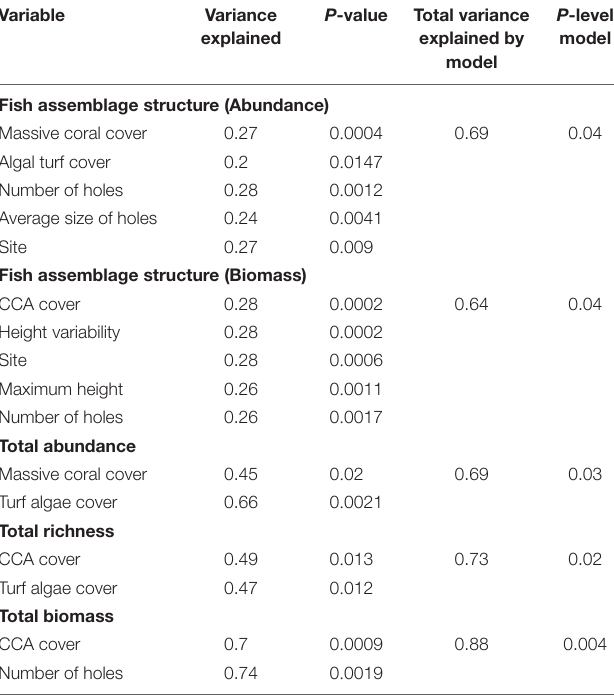
TABLE 2 | Variables selected to construct linear models based on distances that best explained variation in abundances, biomass, richness and species-specific biomass of